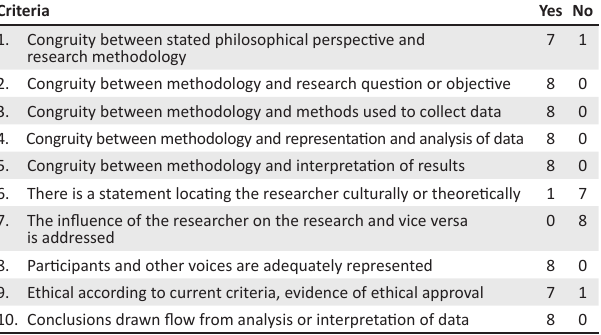
TABLE 2: Qualitative studies critical appraisal checklist. Criteria